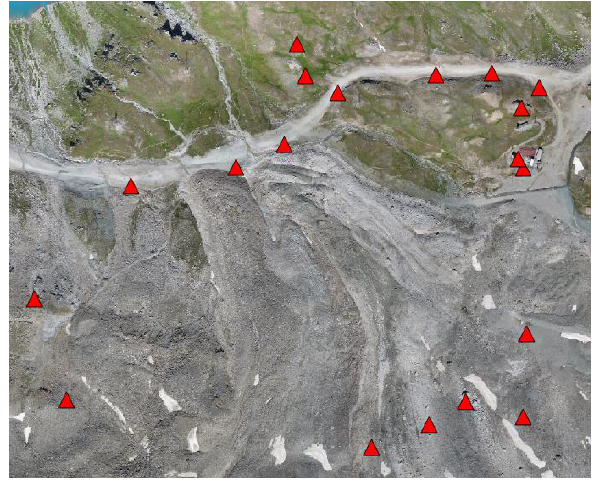
Figure 2: Location of